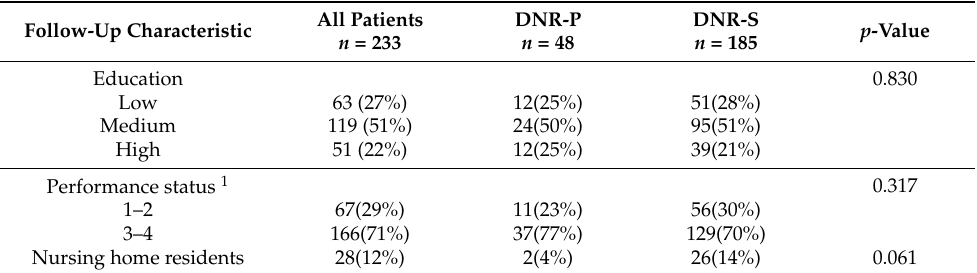
Table A1. Cont. Follow-Up